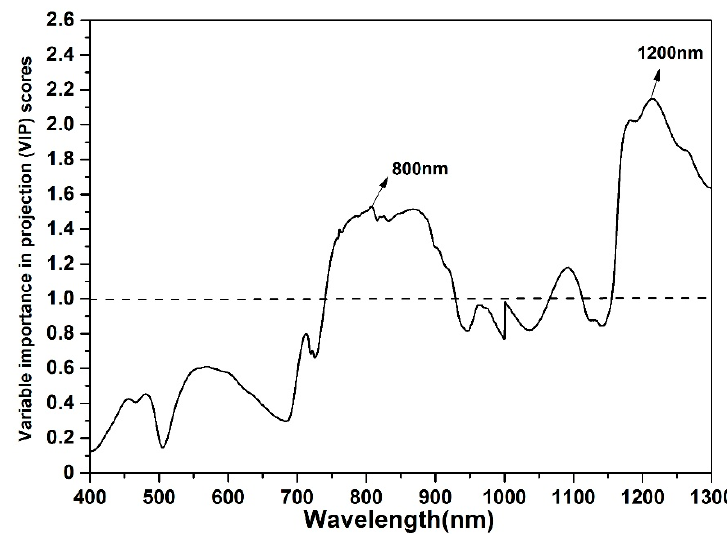
Figure 6. The partial least squares regression variable importance in projection (PLSR VIP) of each wavelength with the combination of four different grown stages data